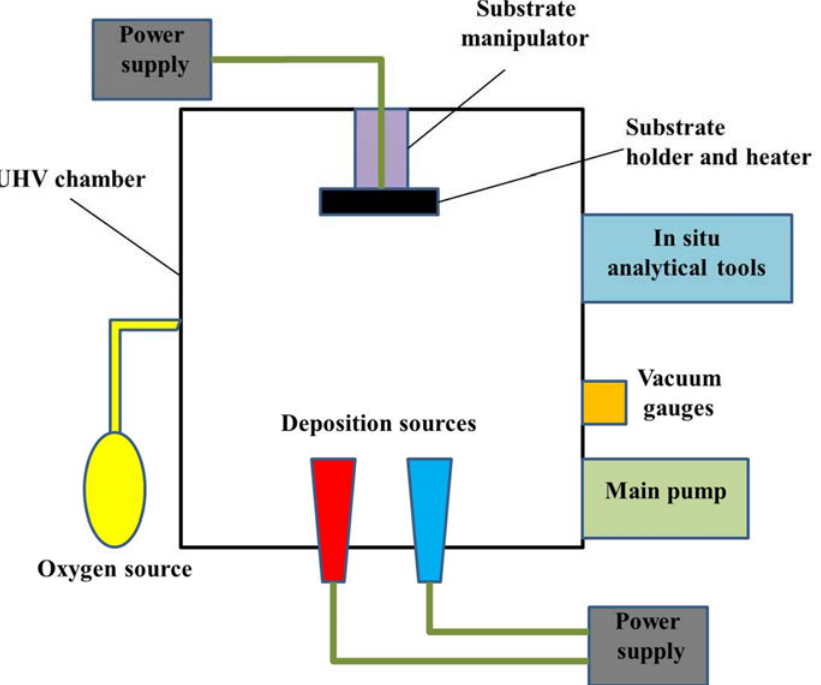
Figure 3. Schematic diagram of a basic physical vapor deposition (PVD) system